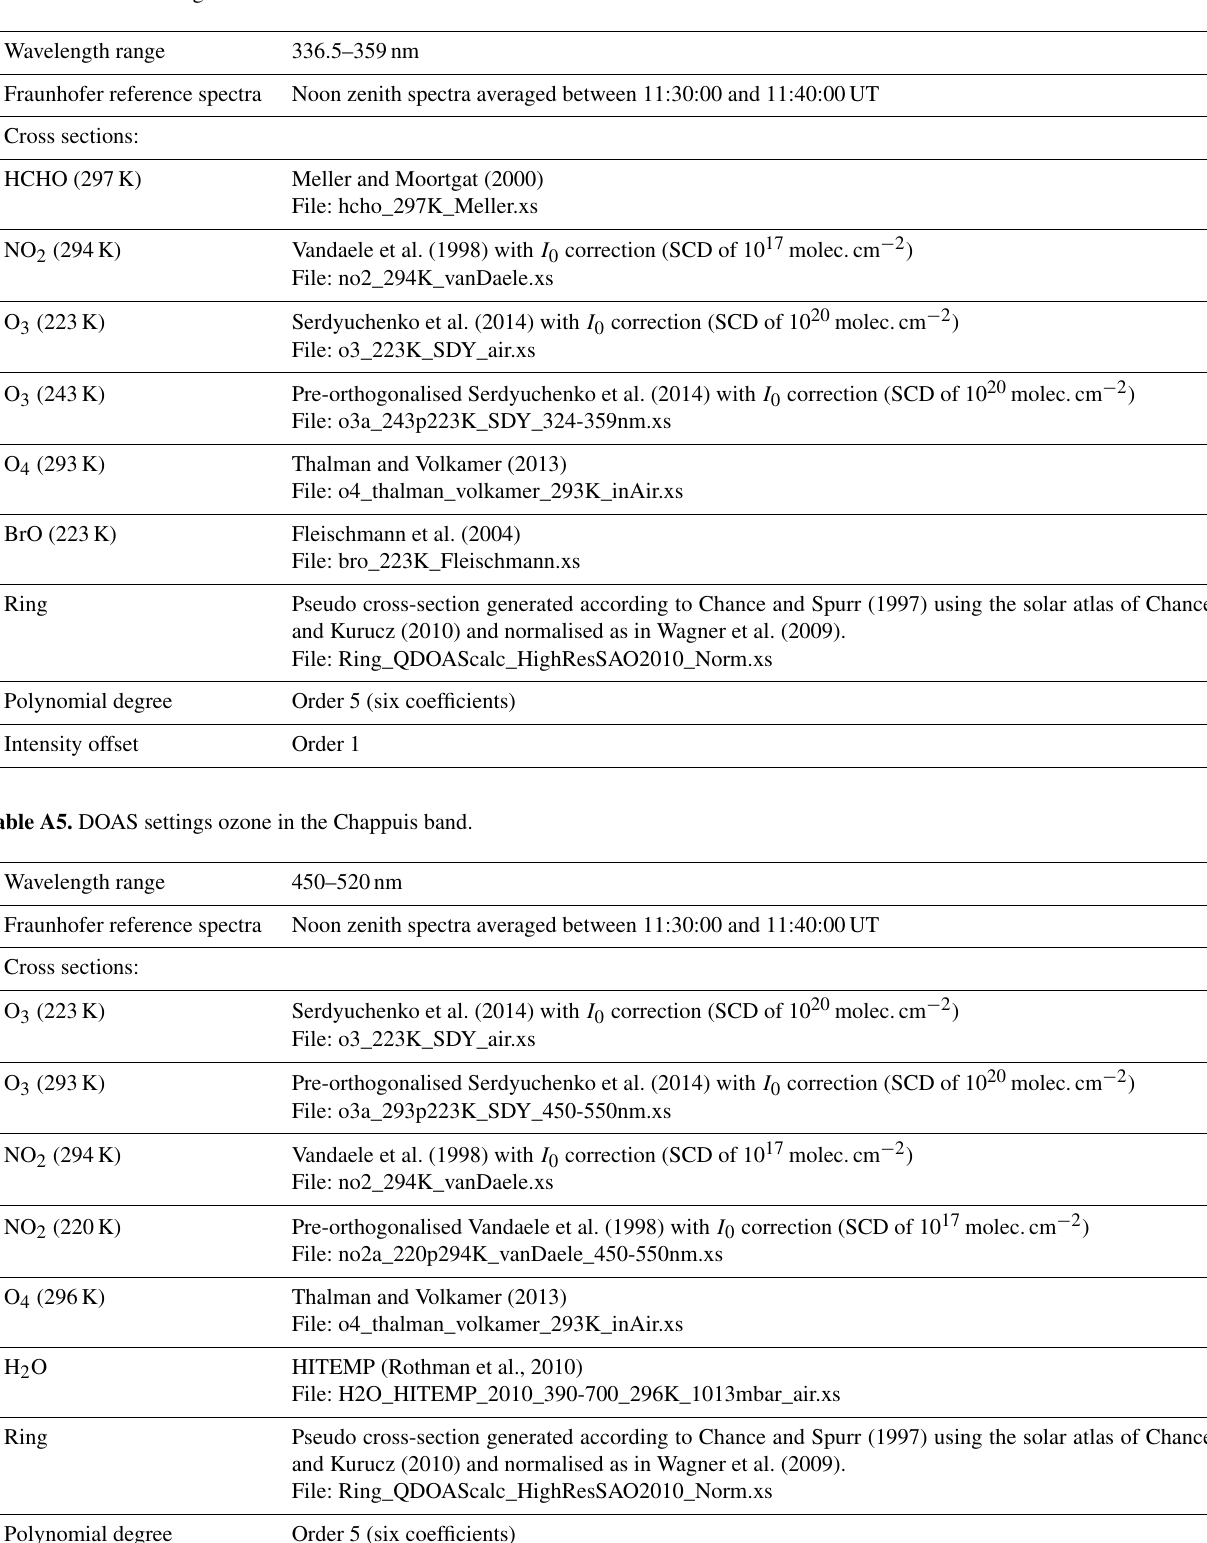
Table A4. DOAS settings for HCHO.